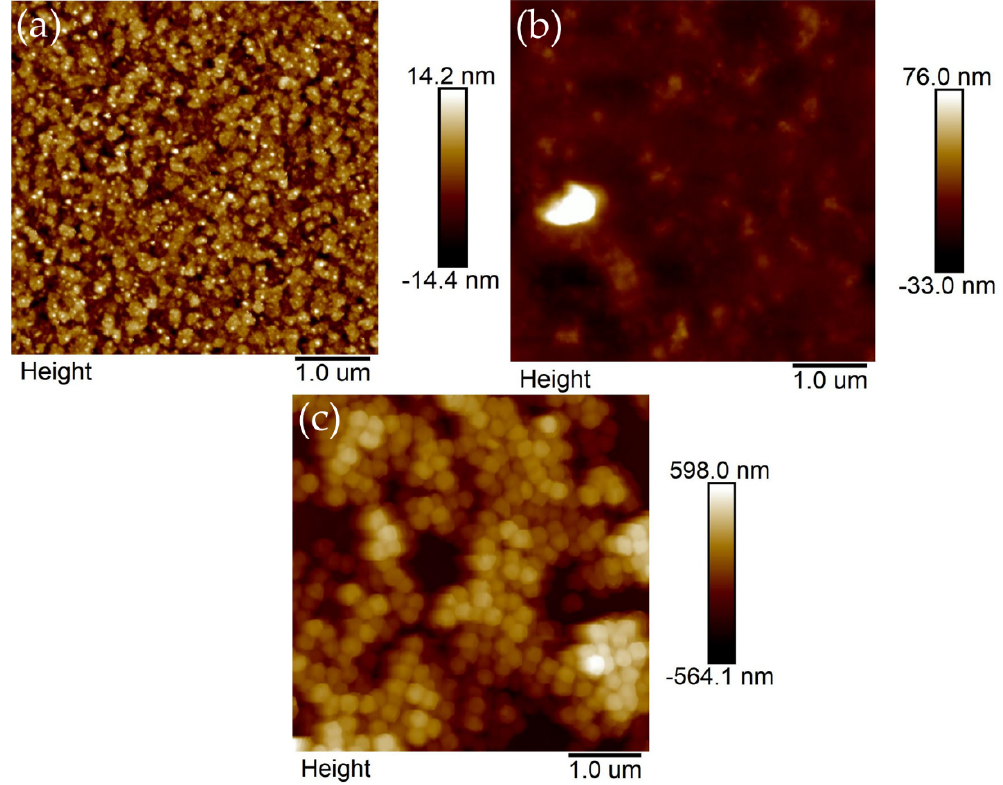
Figure 2. Two dimensional AFM images for ( a ) bare ITO ( b ) PEDOT:PSS/ITO, and ( c ) ZIF - 8 NPs/PE- DOT:PSS/ITO.